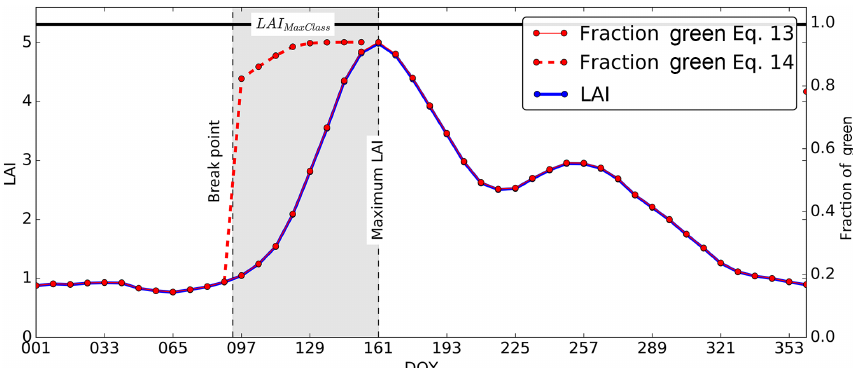
Figure 2. Diagram of fraction of green (Fg) calculation based on the leaf area index (LAI). LAI corresponds to the left ordinate and Fg to the right one. The shading highlights the region in time where Eq. (13) is replaced by Eq. (14). Data presented correspond to an agricultural pixel from the